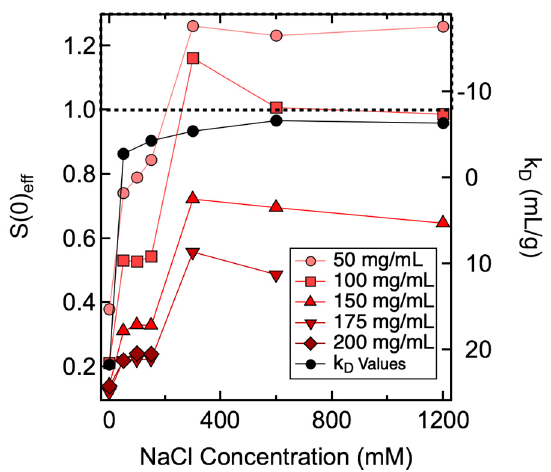
Figure 2. Changes in S(0) eff (left axis) and k D (right axis) values as a function of NaCl concentration. The dotted line represents cut-off values of S(0) eff of 1 and k D of − 8 mL/g. Divided by the dotted line, the top and bottom panel of the figure highlight samples with S(0) eff and k D values that are indicative of attractive and repulsive PPI, respectively. Lines between data points are added to guide the eye. Uncertainties in S(0) eff represent the standard error of the mean for three different structure factor fits; some error bars are smaller than the plotting symbols in this figure. Uncertainties in k D were determined as the propagation of standard errors of the coefficients from the linear regression.